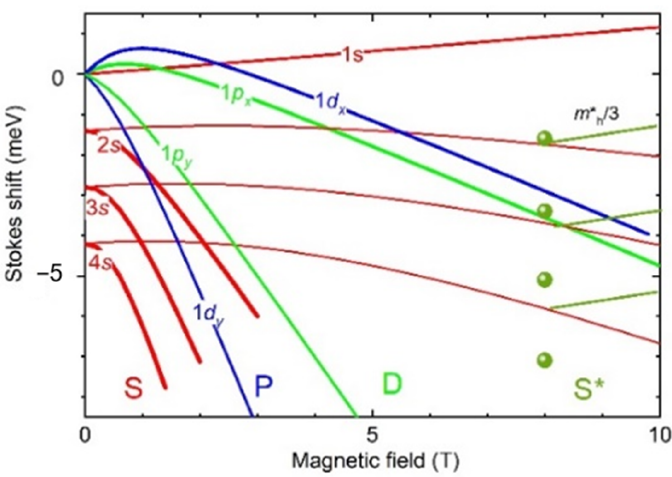
Figure 4. Stokes shift of N’s , 1 p x,y and 1 d x , y states versus magnetic field – thick(thin) curve for electron charge of 1(1/7), balls—experiment for S*. Transition to positive dispersion shown for S*-range corresponds to m h